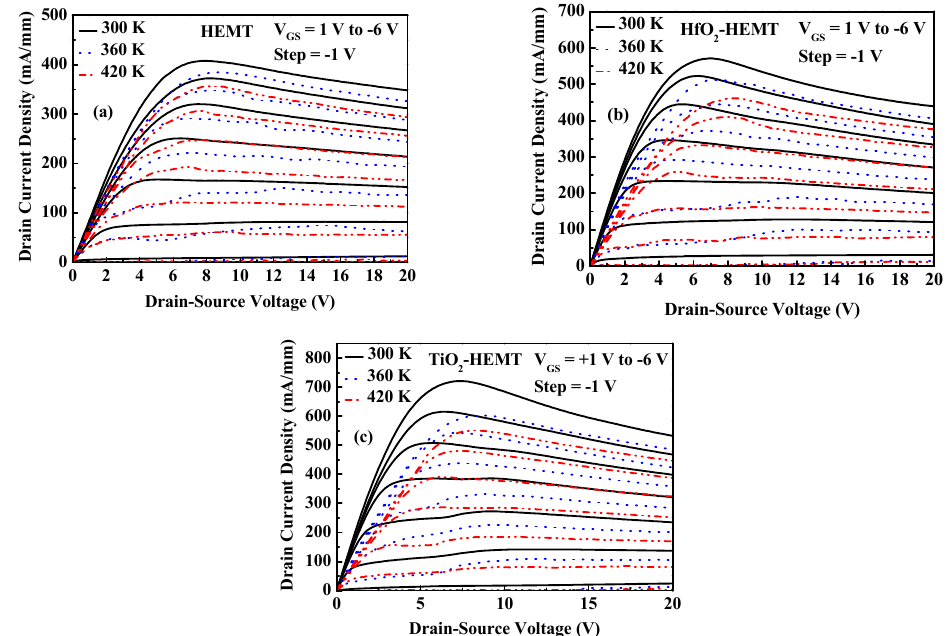
Figure 3. Family of drain-source output curves of ( a ) HEMT, ( b ) HfO 2 -HEMT, and ( c ) TiO 2 -HEMT at various temperatures.